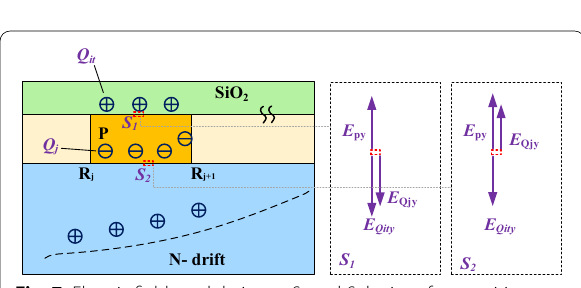
Fig. 7 Electric field modulation at S 1 and S 2 by interface positive charges ( Q it ), effective charges ( Q j ) and applied potential